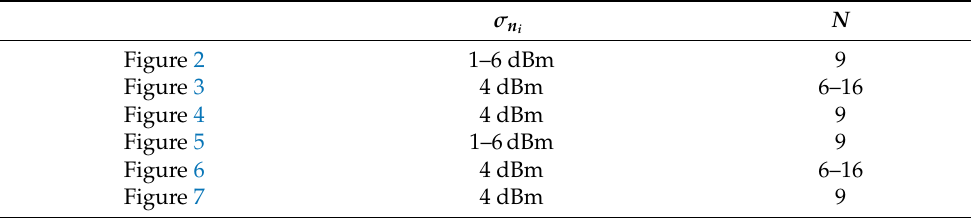
Table 3. Variables in Figures 2–7.